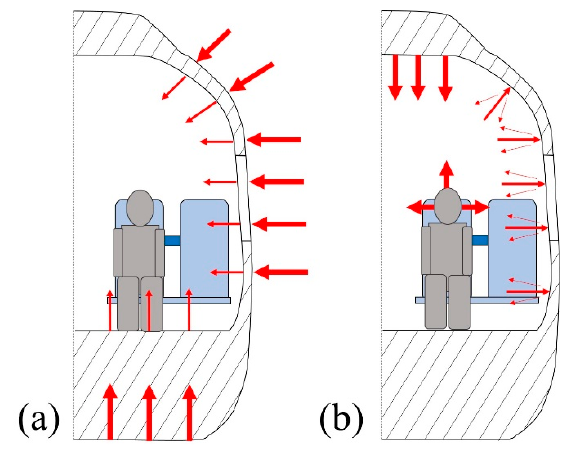
Figure 9. Noise progression: ( a ) external transmission and ( b ) internal reflection.